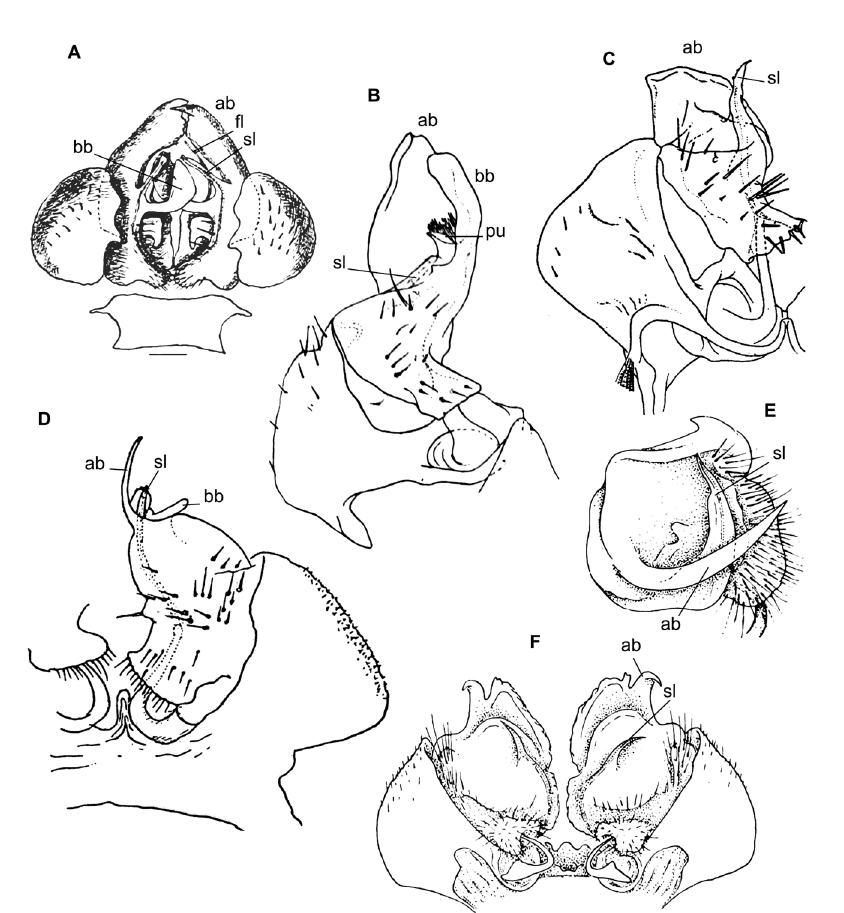
Figure 1. Gonopods of the type species of some African Trichopolydesmidae. A Sphaeroparia minuta Attems, 1909 (after Attems 1909) B Sphaeroporia ( Megaloparia ) lignivora Brolemann, 1920 (after Brole- mann 1920) C Sphaeroparia ( Physetoparia ) imbecilla Brolemann, 1920 (after Brolemann 1920) D El- Kraus 1958). Reproduced not to scale. Abbreviations: ab apical branch of telopodite, bb basal branch of telopodite, fl flagellum, lo lobe, sl solenomere, pu